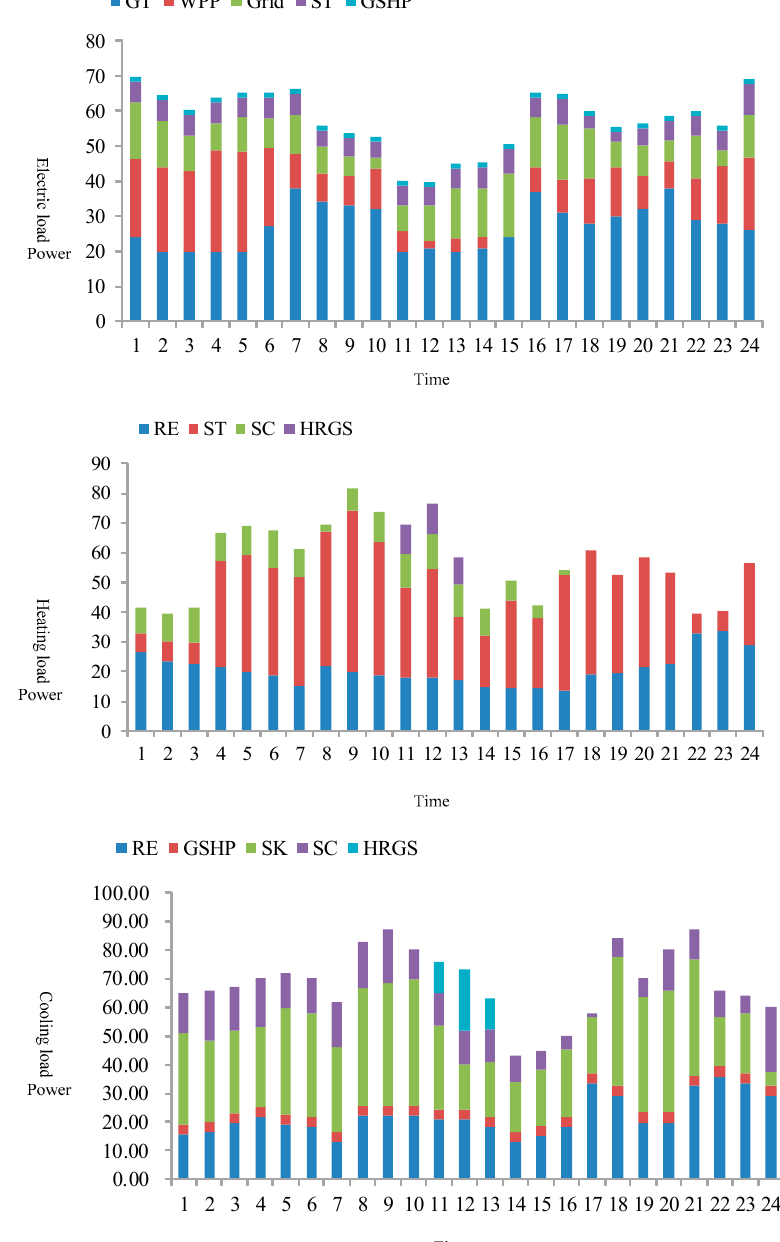
Figure 6. Hourly electric, heating, and cooling load supply of scenario 2 (unit: MW).